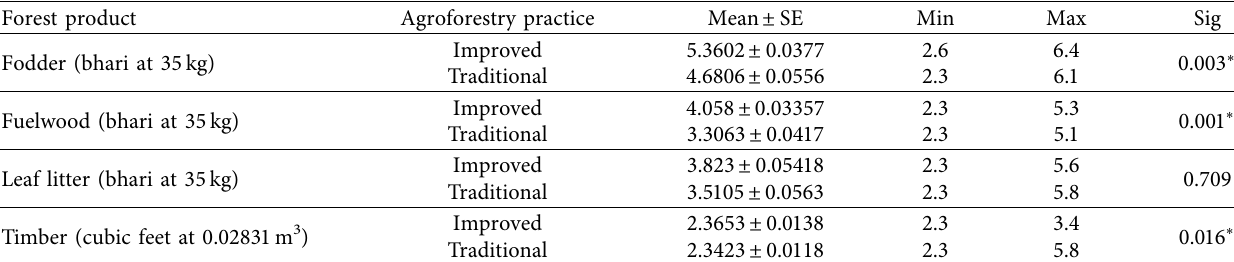
Table 2: Supply of forest products from different agroforestry practices.